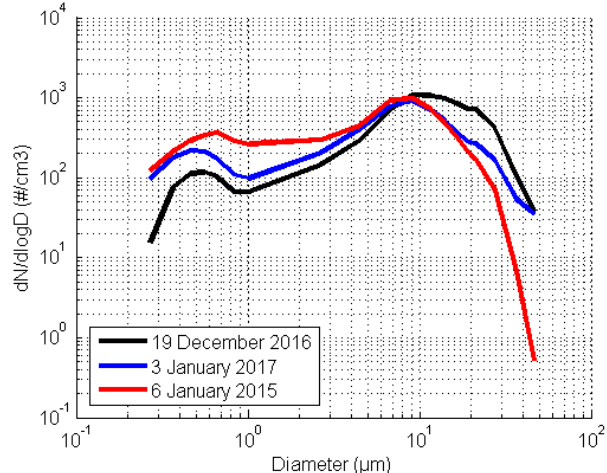
Figure 8. Particle size distribution measured with LOAC for 19 December 2016, 3 January 2017 and 6 January 2015 along the tethered balloon path.